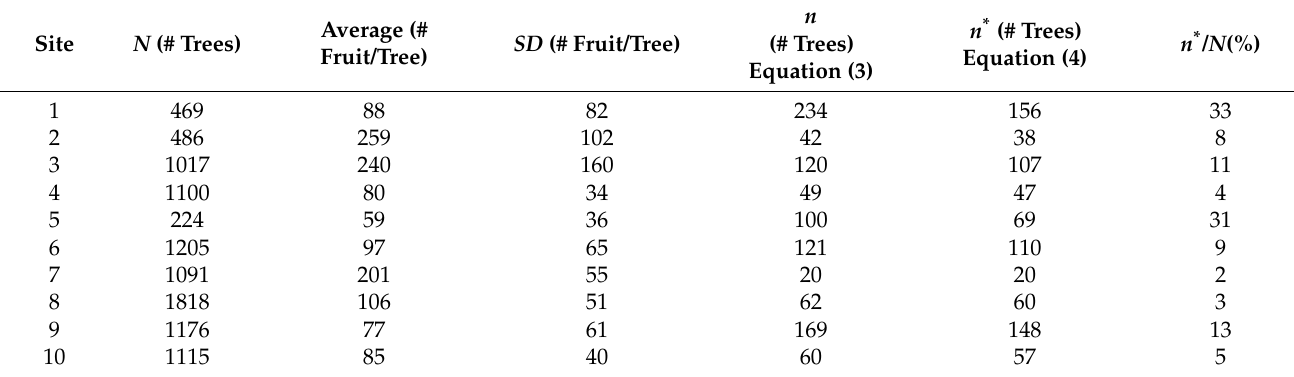
Table 3. Calculated sample sizes n (Equation (3)) and adjusted sample size n ∗ (Equation (4)) required for SRS with a 90% confidence and a PE of 10% based on an estimated SD from a preliminary sample taken from the population of N trees. Data from Anderson et al. [16]. # represents